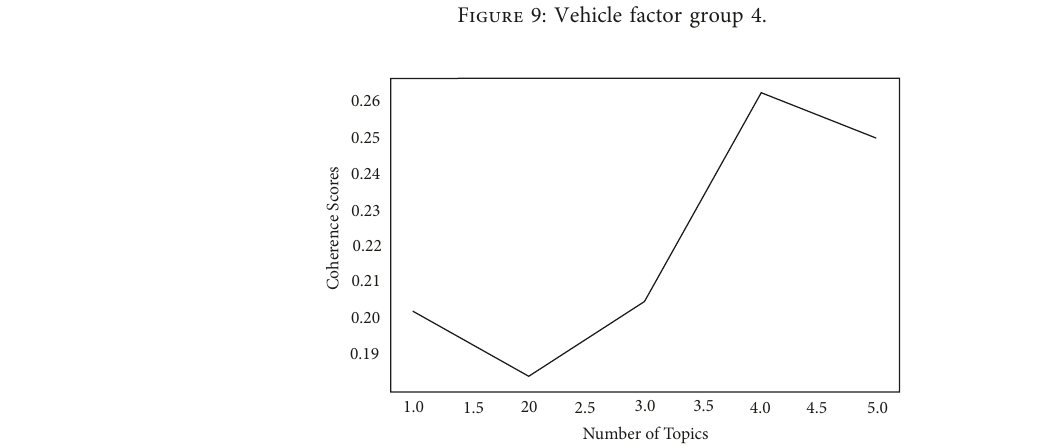
Figure 10: Coherence score of other factor. Table 9: Other factor topic modeling group